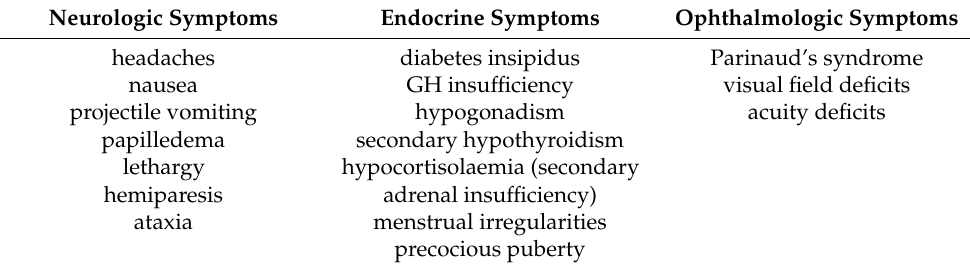
Table 1. Clinical